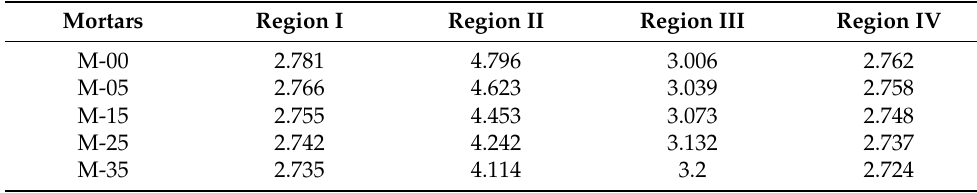
(cid:16) (cid:17) (cid:0) (cid:1) Figure 7. vs. and the values in the mortars: ( a ) M-00, ( b ) M-05, ( c ) M-15, W n / r 2 n V 1/3 n / r n Figure 7. ln vs. ln and the D S values in the mortars: ( a ) M-00, ( b ) M-05, ( c ) M-15, ( d ) M-25, ( e ) M-35, and ( f ) the values in Region I and Region IV of mortars. ( d ) M-25, ( e ) M-35, and ( f ) the D S values in Region I and Region IV of mortars. Table 3. The of geopolymer mortars. Table 3. The D S of geopolymer